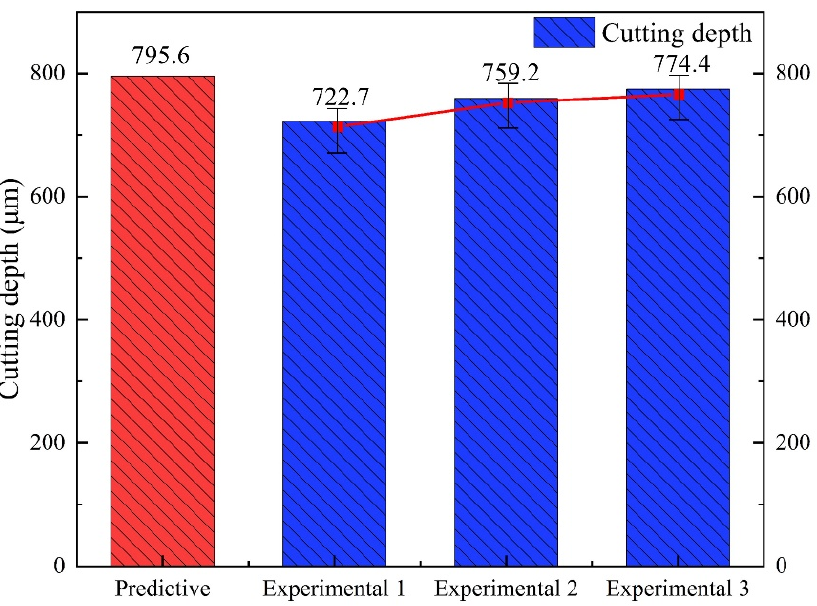
Table 8. Experimental results of the optimal parameters.